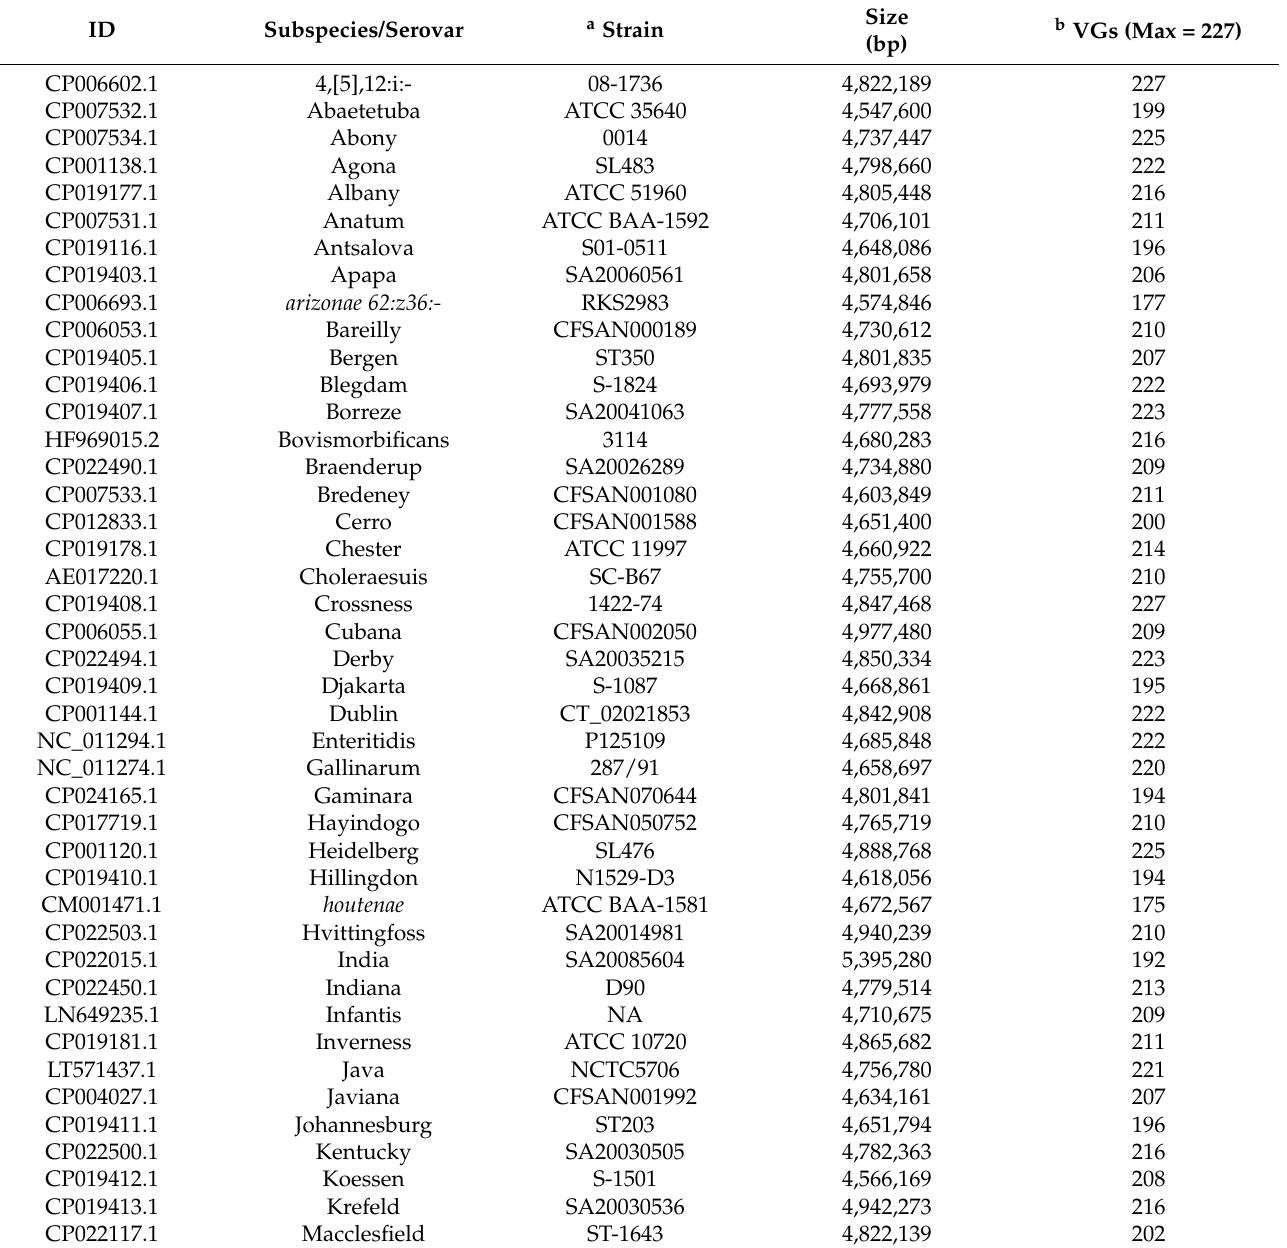
Table 1. Salmonella reference genomes used in the design of AmpliSeq Salm_227VG panel and their distribution of 227 known virulence